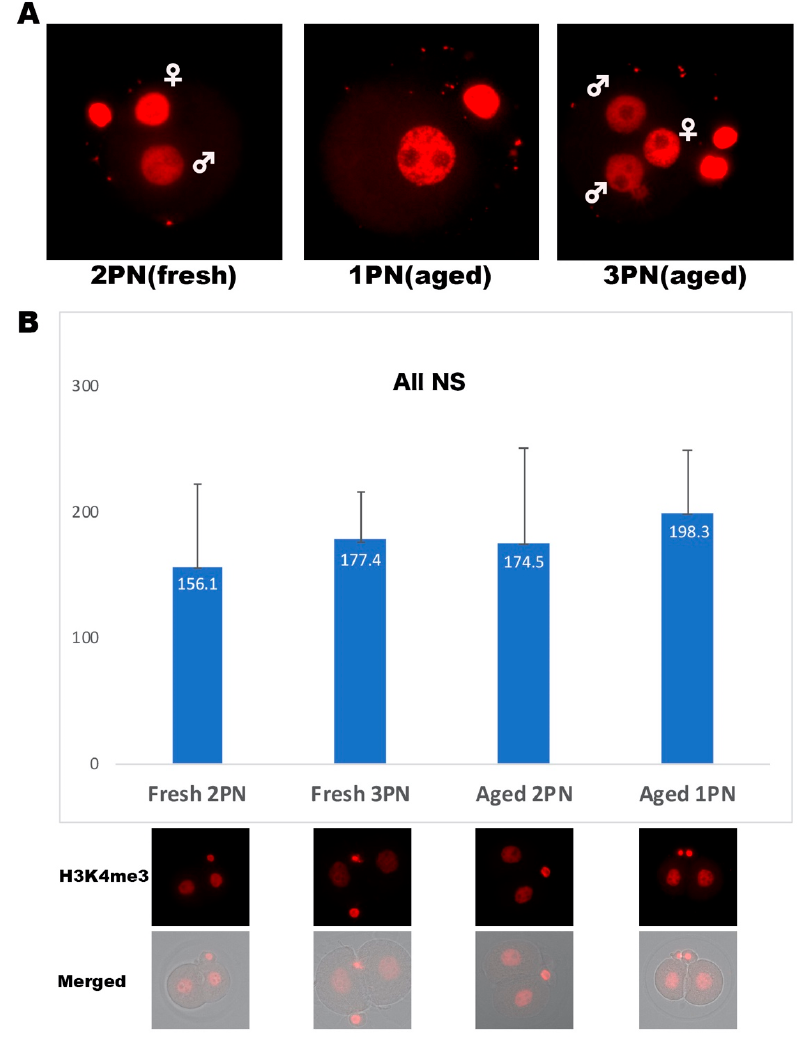
Figure 4. Global methylation analysis by trimethylation of histone H3 lysine 4 immunostaining. ( A ) Figures depict immunostaining of antibody against H3K4me3 in “fresh” 2PN, “aged” 1PN, and “aged” 3PN embryos. ♂ and ♀ indicate male and female pronuclei, respectively. Images were captured using 40× objective. ( B ) Signal intensity of H3K4me3 in 2-cell embryos derived from “fresh” 2PN, “fresh” 3PN, “aged” 2PN, and “aged” 1PN are shown. Bottom images show 2-cell-stage embryos from each origin. NS indicates statistically not significant.